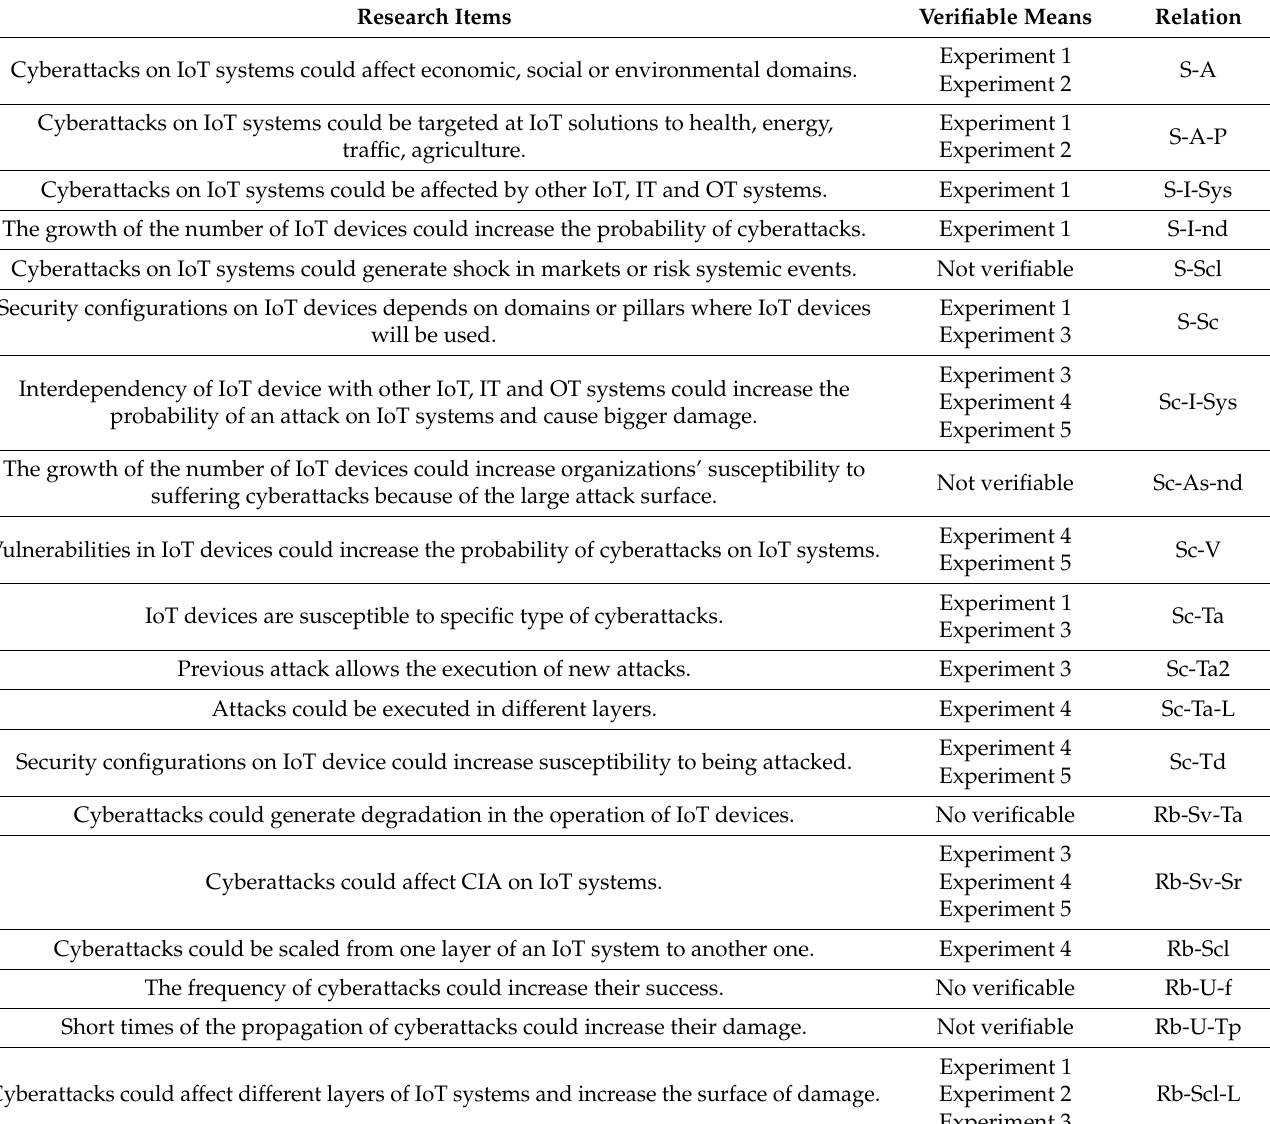
Table 6. Research items validated in experimentation to identify the relation between factors of IoT